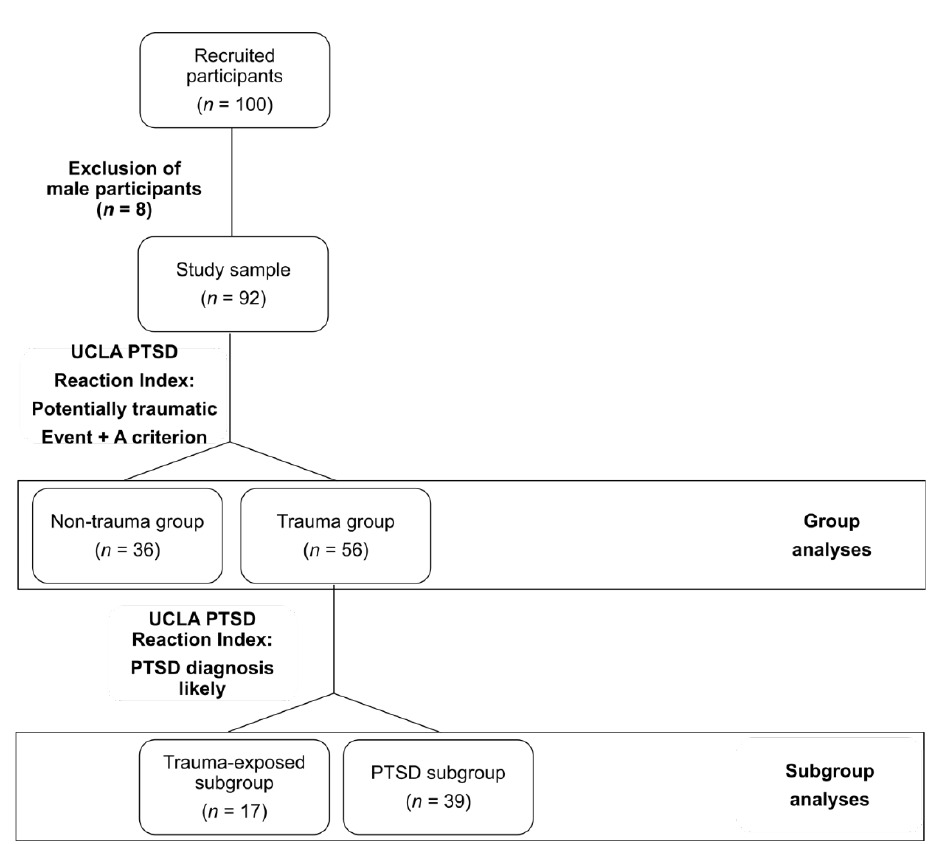
Figure 1. Flowchart of group allocation based on the UCLA PTSD Reaction Index for DSM IV, Child Version.